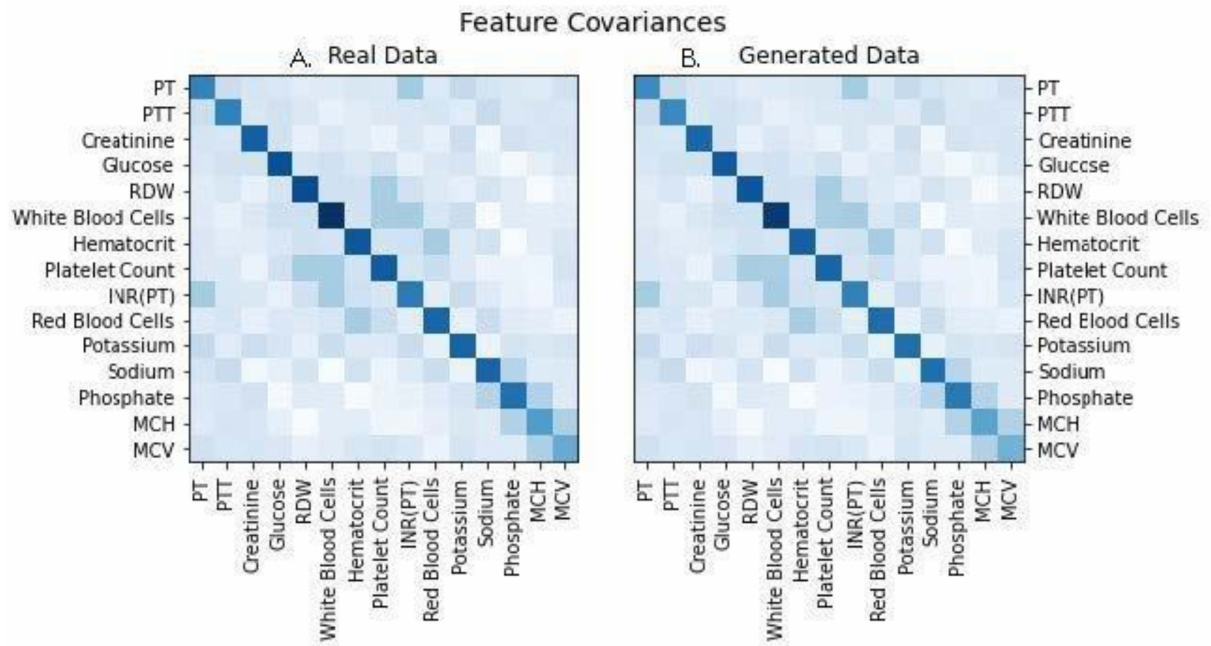
Figure 4. Covariance structure matrices for the two datasets to visualize the similarity between real and simulated data, indicating accurate trajectory of simulated data when compared against real patient data. Abbreviations used: PT: prothrombin time; PTT: partial thromboplastin time; RDW: red cell distribution width; INR: international normalized ratio; MCV: mean corpuscular volume; MCH: mean corpuscular hemoglobin. ( A ) represents Real Patient Data while image ( B ) represents Generated Data.